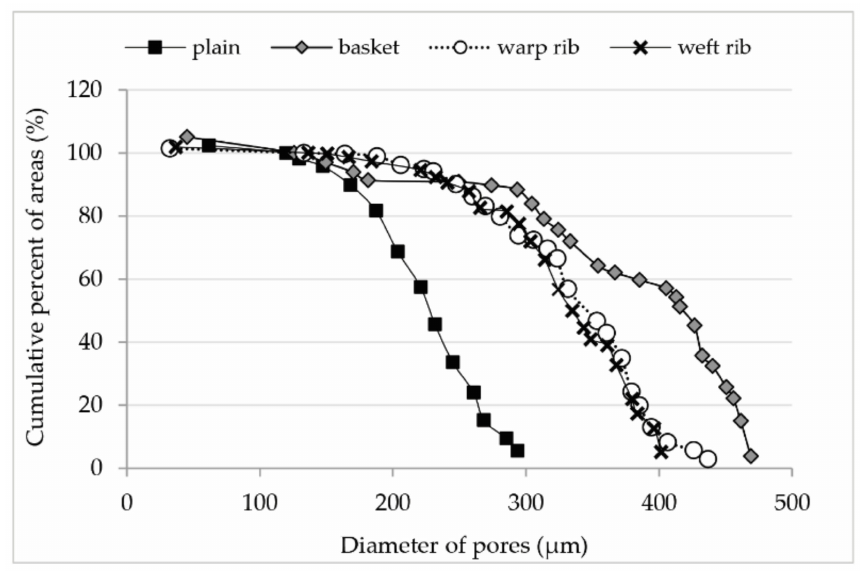
Figure 4. Cumulative percentage of areas in relation to pore diameter for all four weaves.